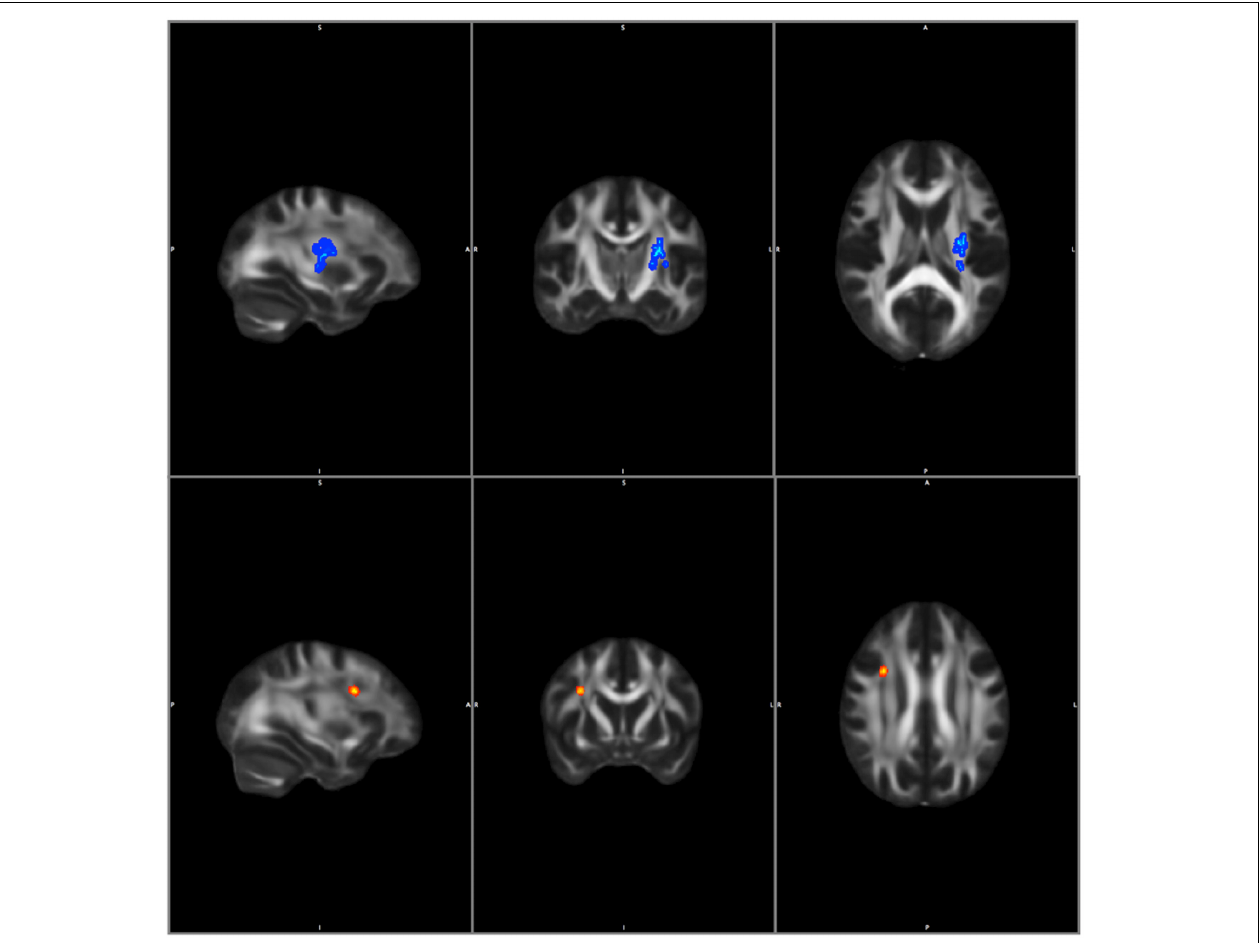
FIGURE 3 | Correlation with clinical parameters in MwA. Blue color shows negative correlation with disease duration and red color shows negative correlation with attack number to axial diffusivity. Statistical images are thresholded at p < 0.05 corrected for multiple